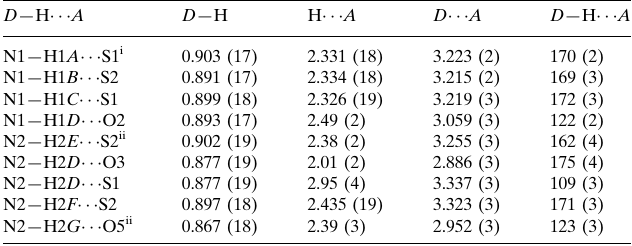
Hydrogen-bond geometry (A˚ , (cid:3)